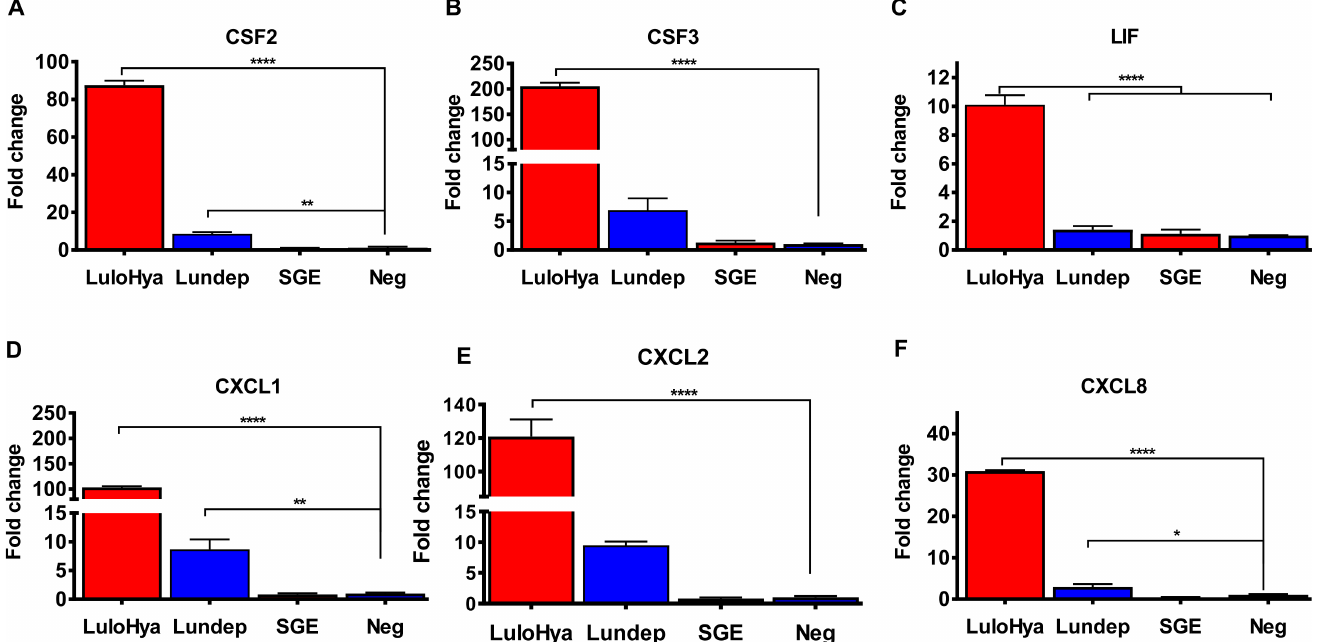
Fig 6. Validation of gene expression of cytokines and chemokines from HMVEC cells in the presence of LuloHya, Lundep or SGE. RT-PCR for validation of gene expression results obtained with the Human Cytokines & Chemokines RT 2 Profiler PCR Array PAHS-150ZD. Specific set of primers were used to amplify (A) CSF2; (B) CSF3; (C) LIF; (D) CXCL1; (E) CXCL2 and (F) CXCL8. Biological triplicates and technical duplicates were analyzed. Negative controls consisted of cDNA isolated from HMVEC cells incubated with incomplete medium. Results are expressed as the fold change of the gene expression normalized against the standard gene HPRT1 (NM_000194). Multiple comparisons were done by one-way ANOVA ( (cid:3)(cid:3)(cid:3)(cid:3) : p < 0.0001; (cid:3)(cid:3) : p < 0.01; (cid:3) : p < 0.05). Bars indicate the SEM.